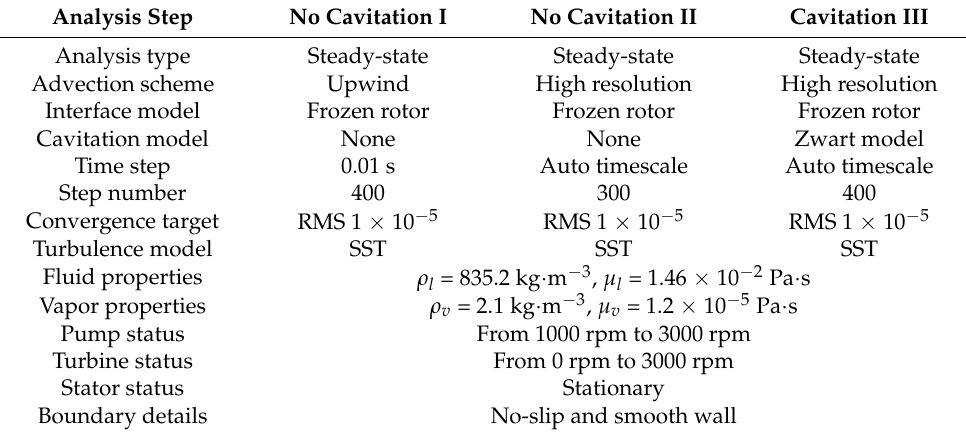
Table 1. Detailed setting of torque converter CFD